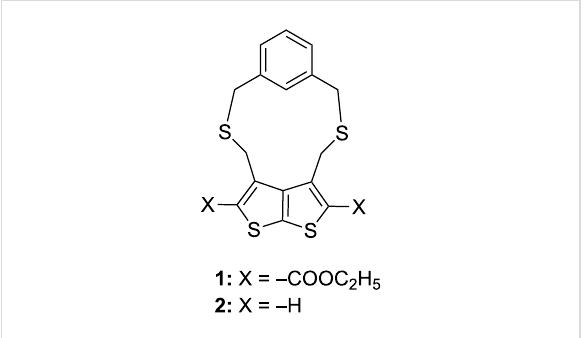
Figure 1: Conformationally flexible 3, 4-bridged dithia-thienothiophen-